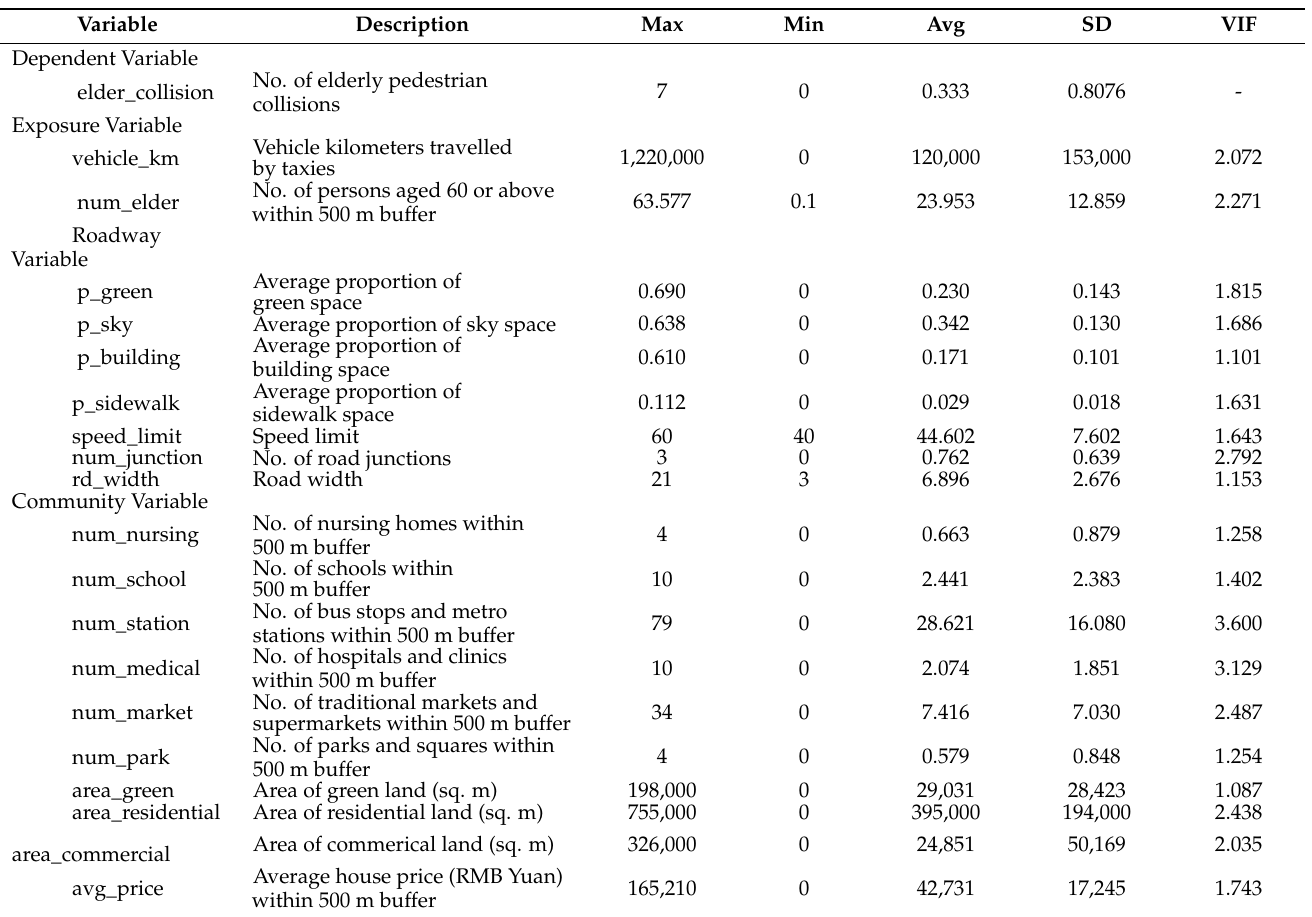
Table 1. Descriptive statistics of dependent and independent